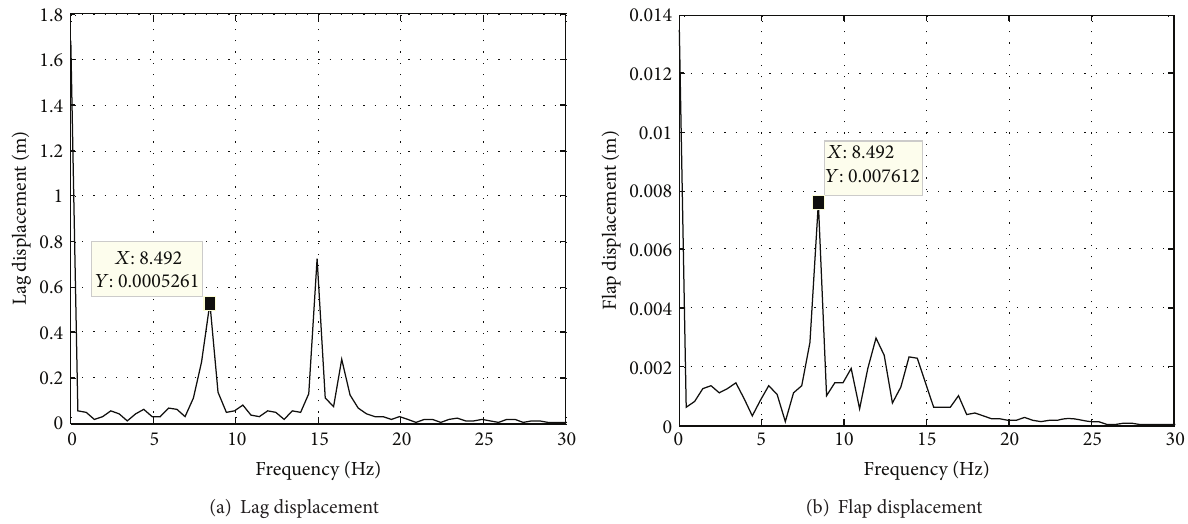
Figure 11: Frequency response of the lag and flap displacements at the tip due to impulse